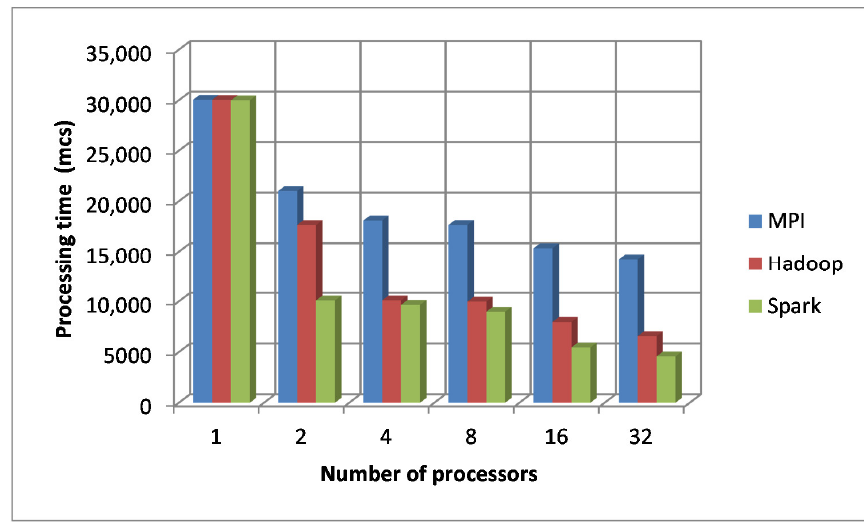
Figure 14. Processing time of SVD in the size 1500 for various technologies of distributed data processing versus number of processors.